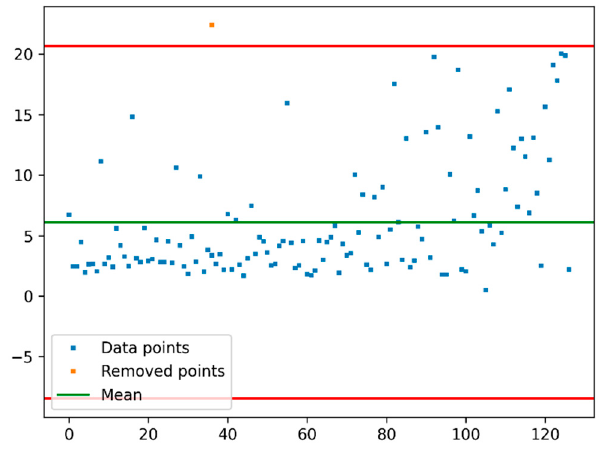
Figure 7. Endpoint distribution for logarithm values of equilibrium constants for Eu 3+ complexation: in green the endpoint average, in red the upper and down limits that are 3 σ from the mean.